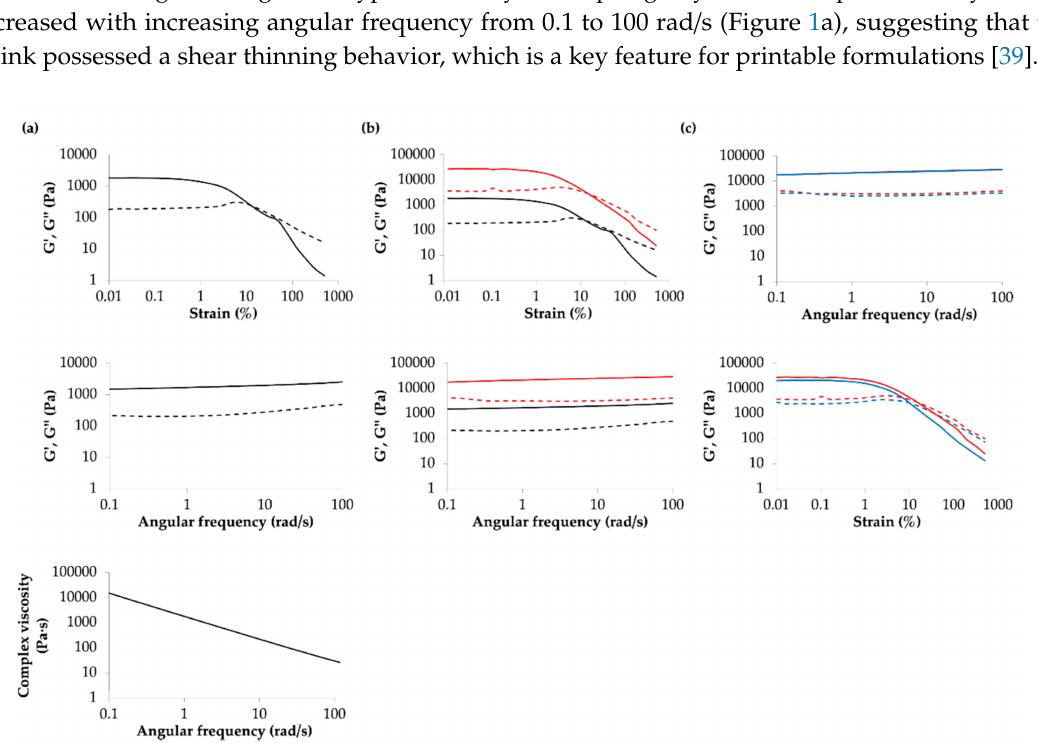
Figure 1. Rheological characterization of the bioink: ( a ) storage (G’, continuous line) and loss (G”, dashed line) moduli trends as a function of applied strain and angular frequency, both at 25 ◦ C, and complex viscosity trend as a function of angular frequency for the bioink before crosslinking; ( b ) storage (G’, continuous line) and loss (G”, dashed line) moduli trends as a function of applied strain and angular frequency at 25 ◦ C for the bioink before (black) and after (red) crosslinking; ( c ) storage (G’, continuous line) and loss (G”, dashed line) moduli trends as a function of applied strain and angular frequency at 25 (red) and 37 ◦ C (blue) for the bioink after